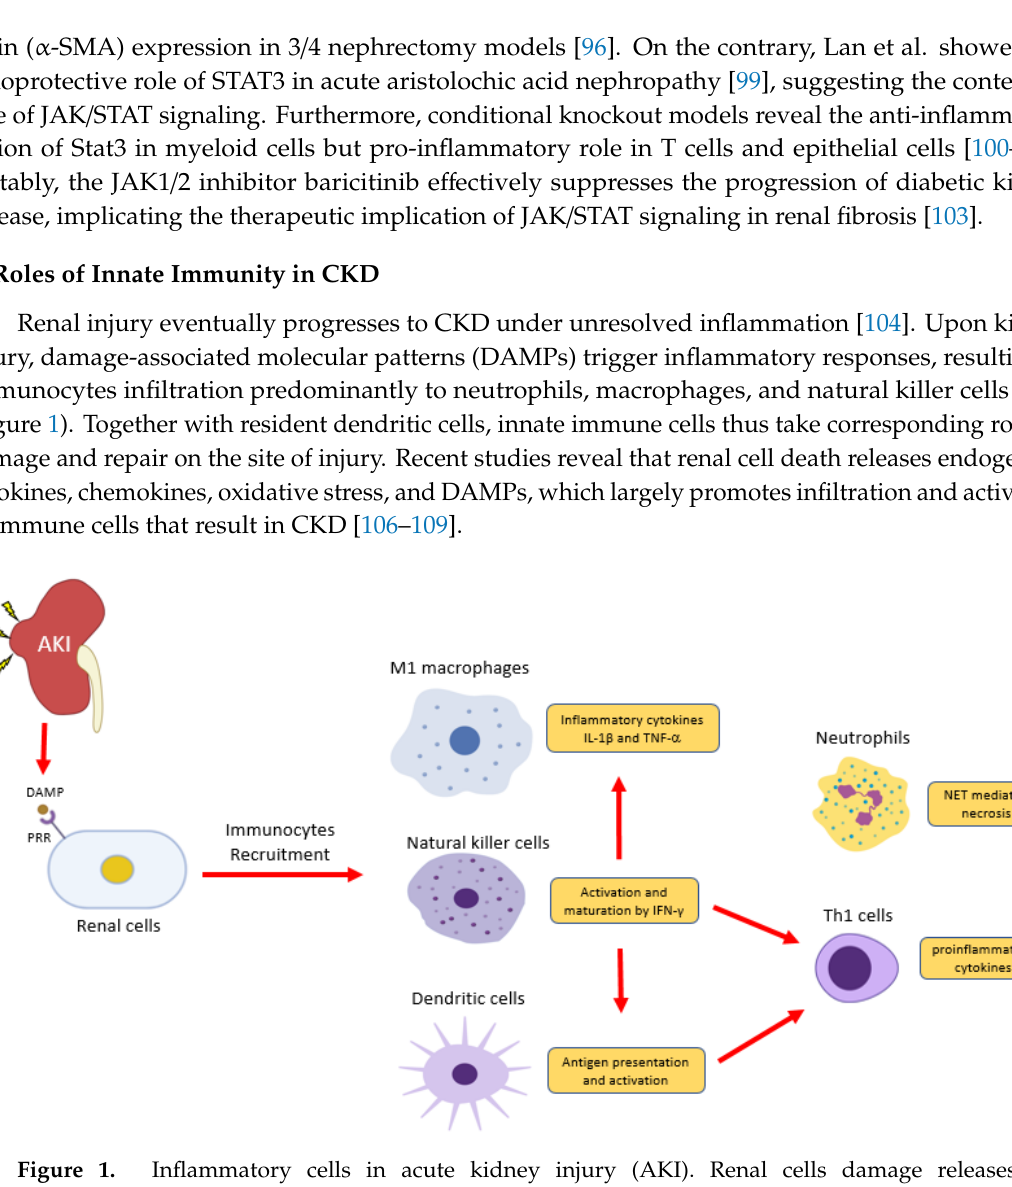
Figure 1. Inflammatory cells in acute kidney injury (AKI). Renal cells damage releases damage-associated molecular patterns (DAMPs) to induce inflammation via pattern recognition receptors (PRRs). Natural killer cells release IFN- γ to induce classical activation of macrophage (M1)- producing pro-inflammatory cytokines IL-1 and TNF2 and induce dendritic cell maturation for pro-inflammatory Th1 differentiation. DAMPs also trigger the release of a neutrophils extracellular trap (NET) to further recruit inflammatory cells and induce renal cell death.